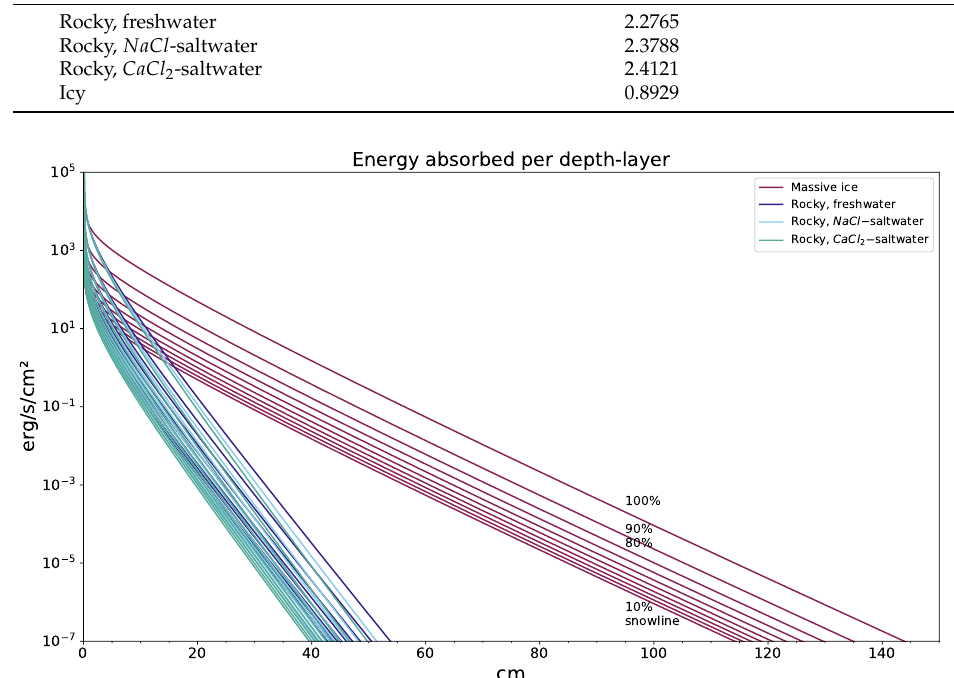
Figure 3. Energy flux absorbed at a certain depth in 4 surface models, with a family of graphs from 10% to 100% snowline distances (descriptions of which are only shown for pure ice models for improved legibility in the graph), with different water-mixtures being very close to each other in the rocky model. What can be clearly seen is that saltwater compositions have a small but noticeable impact on absorption, although the main determining factor of the absorption is material